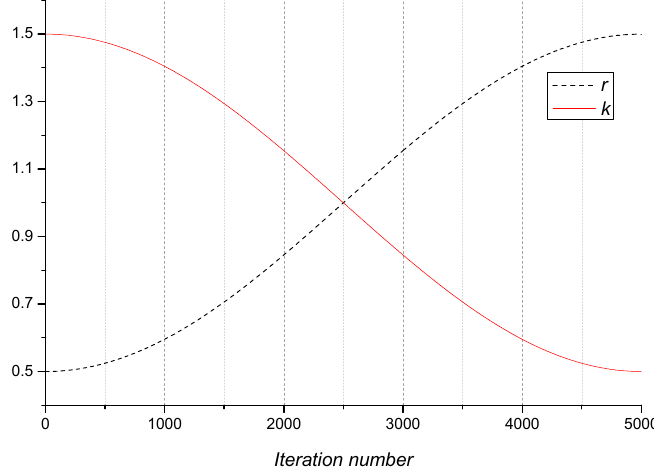
Figure 1. The Regulation operators' evolution curves.